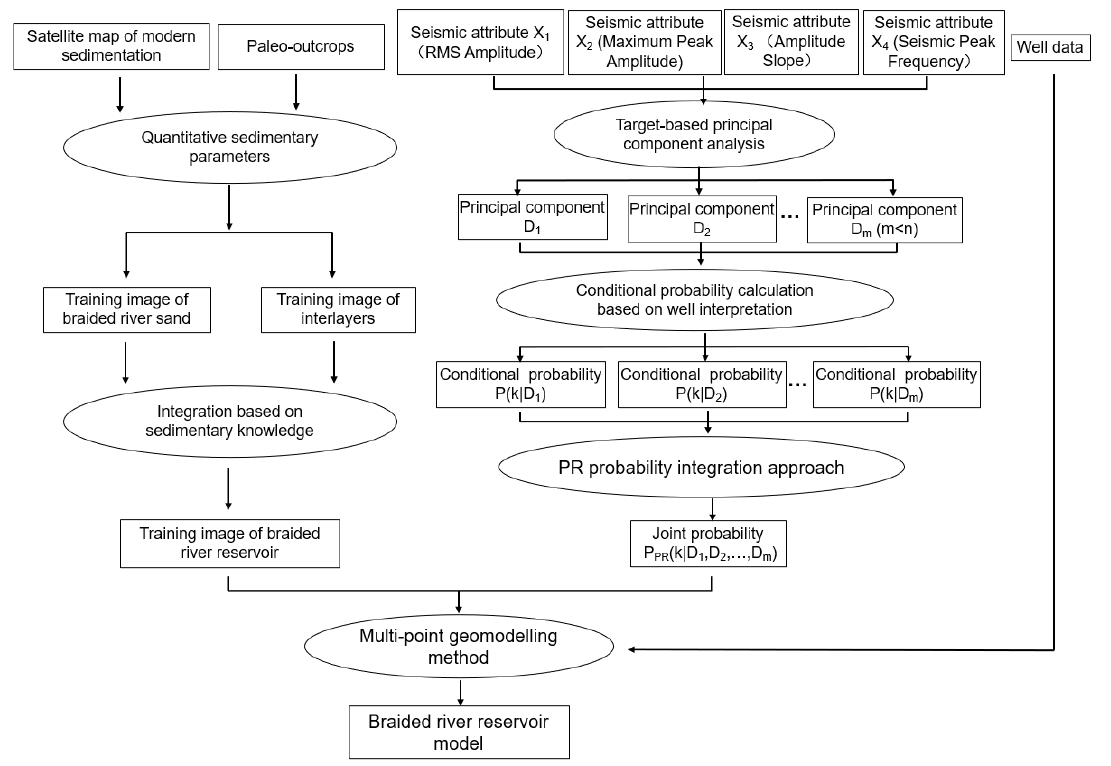
Figure 1. The workflow for the new method to predict braided river reservoir distribution and modeling based on probability fusion and multi-point geostatistics.